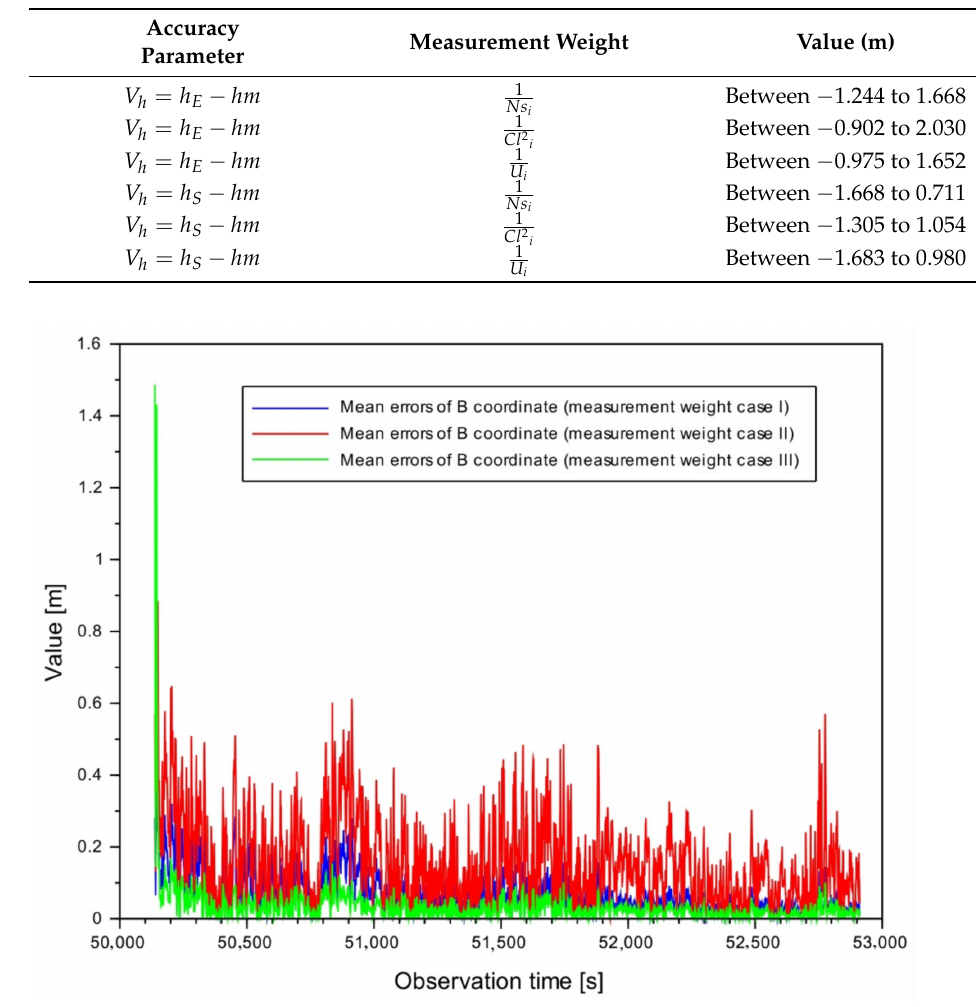
Figure 7. Mean errors of B resultant